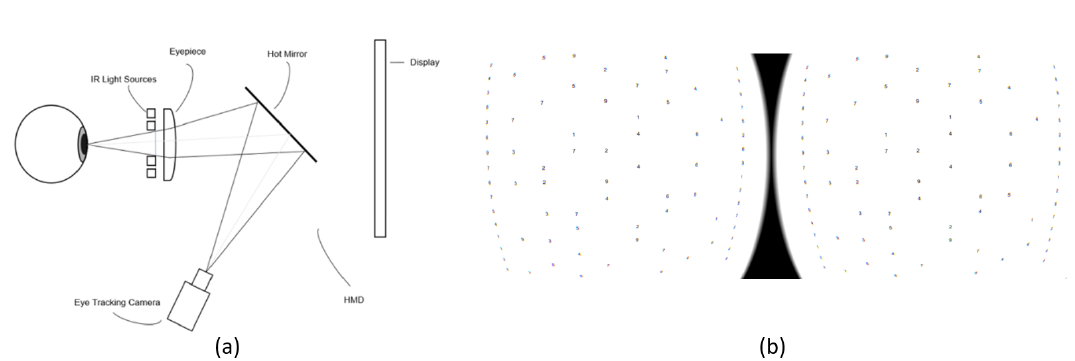
Figure 1. A schematic diagram of the proposed method for measuring saccadic eye movement using a virtual reality (VR) head-mounted display (HMD): ( a ) Eye-tracking module in the HMD; ( b ) The Developmental Eye Movement (DEM) test chart transplanted to the VR